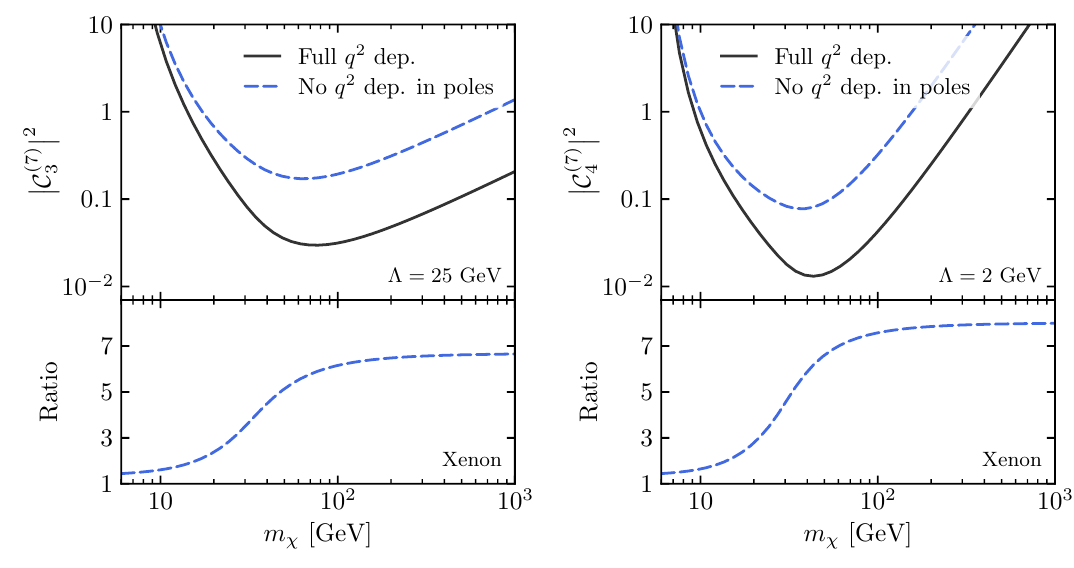
Figure 6 . Comparison between the bounds on the squared Wilson coe(cid:14)cients of the UV operators (7) (7) (left panel) and (right panel) for scattering on a Xenon target. The dashed and solid 3 4 Q Q curves correspond to the bound with and without meson exchanges respectively. The lower plots show the ratio of the bounds without and with the inclusion of meson